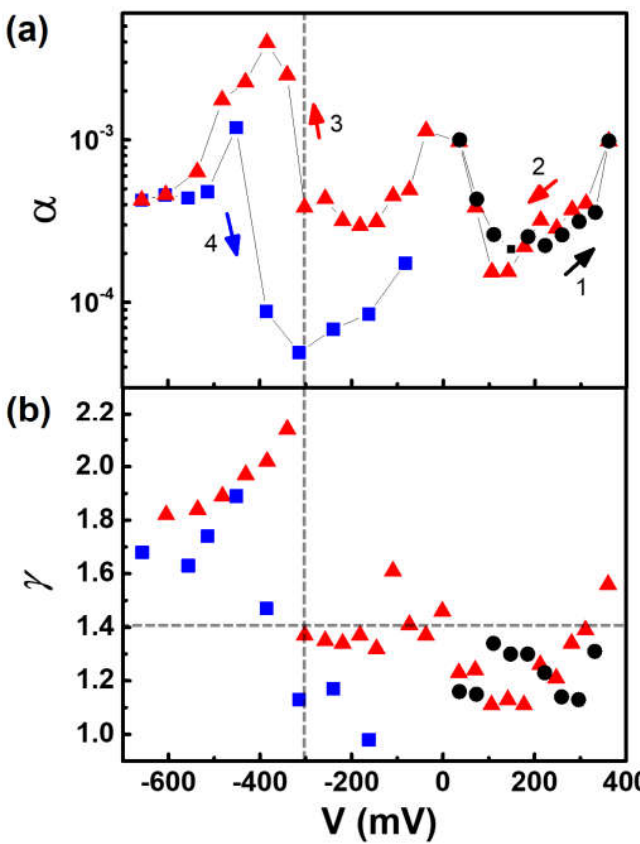
Figure 4. The bias voltage dependence of ( a ) Hooge’s parameter α and ( b ) the exponent γ extracted from noise PSD based on Hooge’s empirical relation.